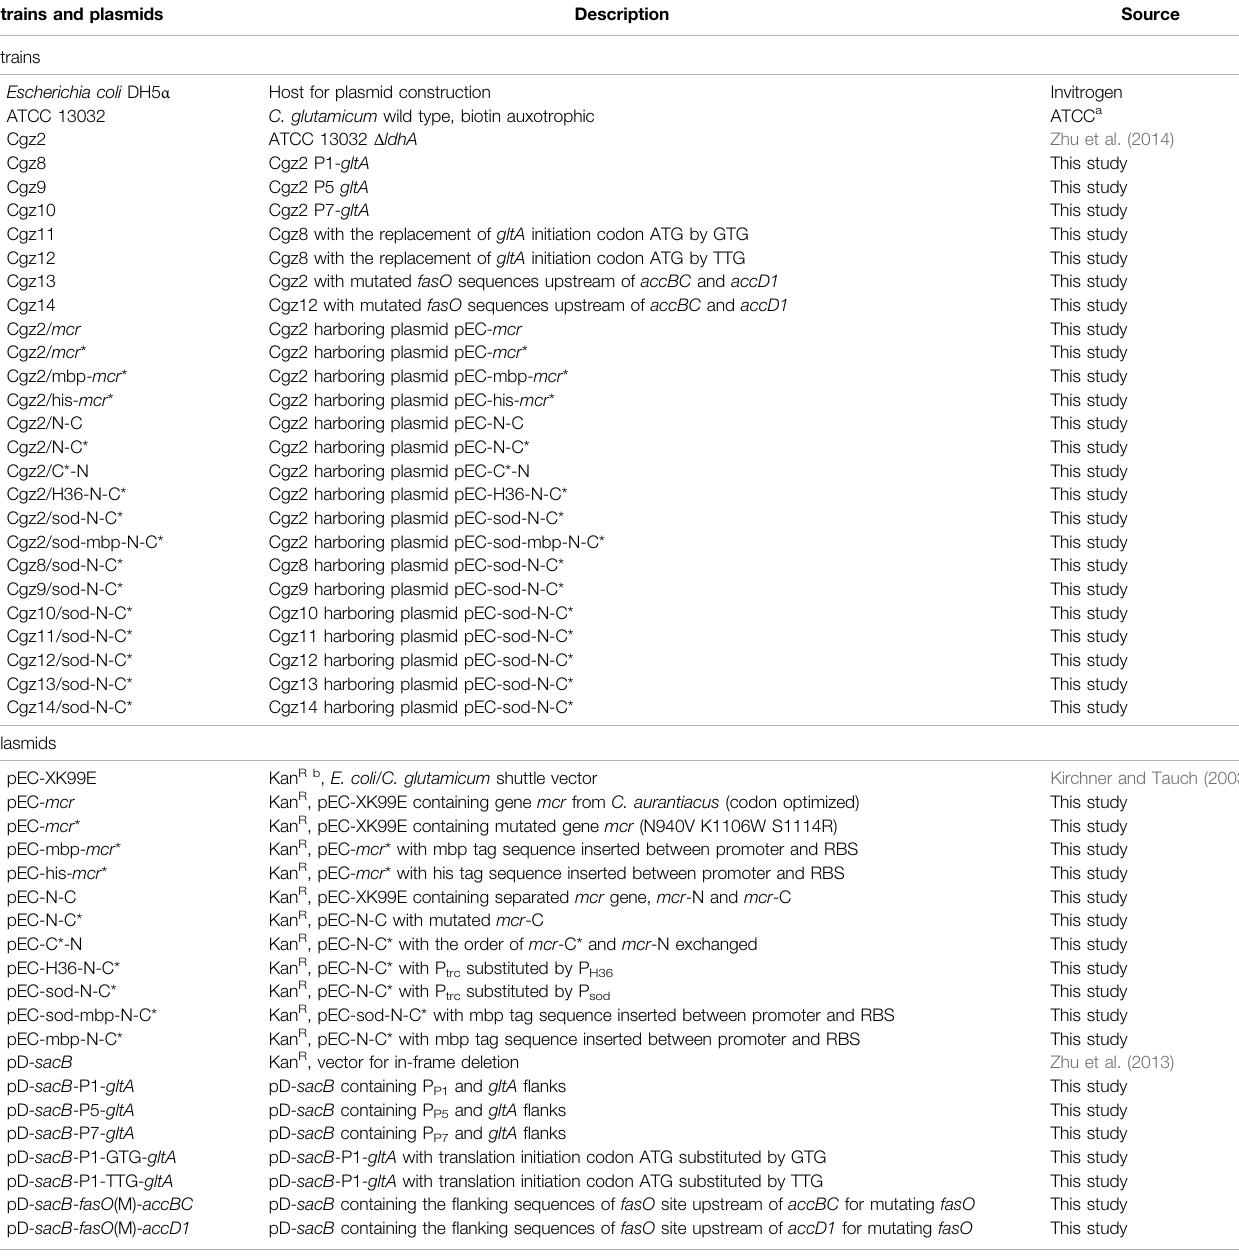
TABLE 2 | Bacterial strains and plasmids used in this